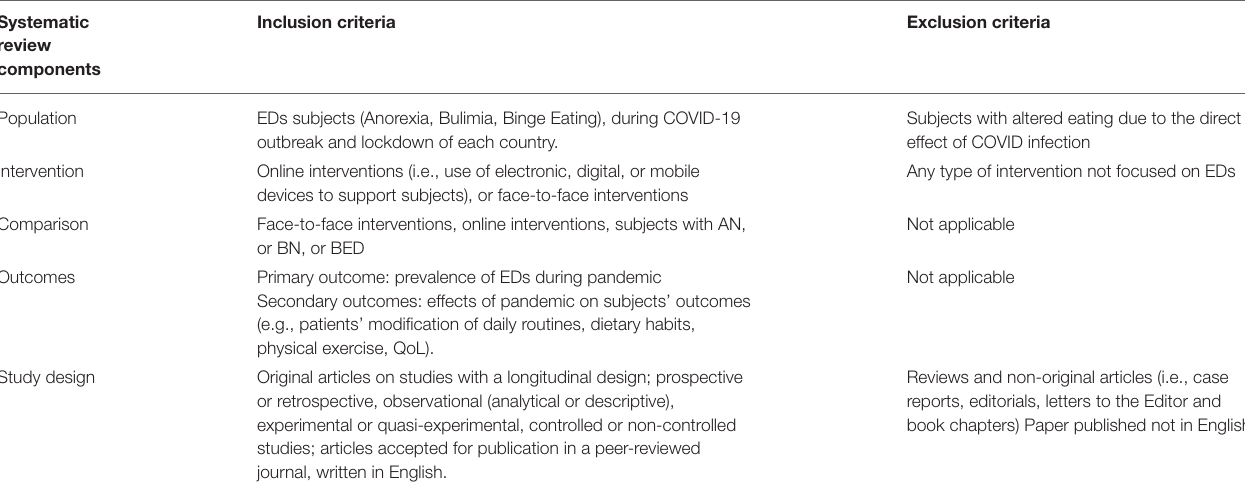
TABLE 1 | Eligibility